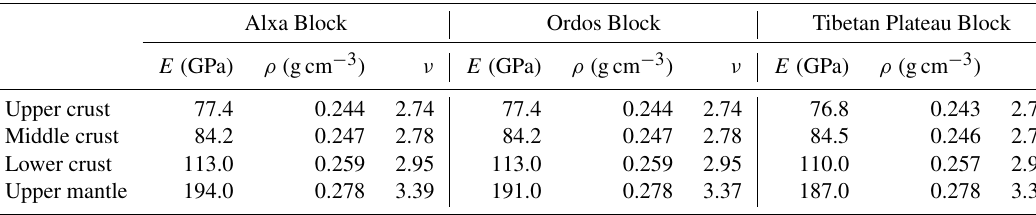
Table 2. Rock properties of the finite-element